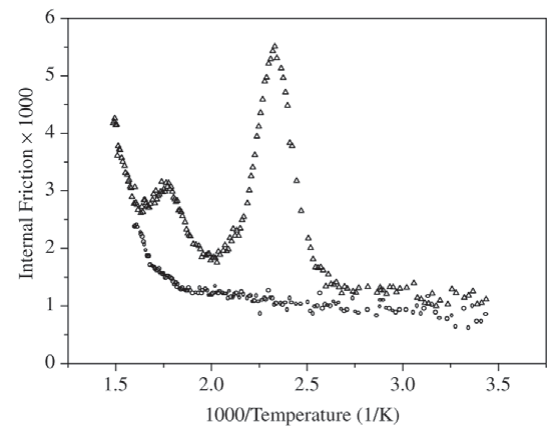
Figure 1. Internal friction as a function of temperature for unalloyed Nb( ∆ ) and Nb-1.2Zr( Ο ).